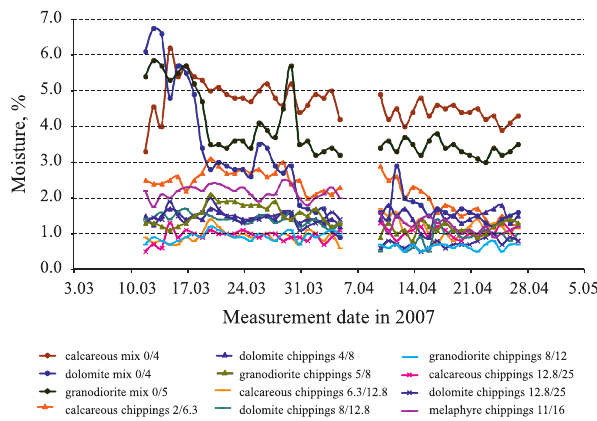
Fig. 1. The aggregate moisture content on the plant site in the AMP Benninghoven in 2007